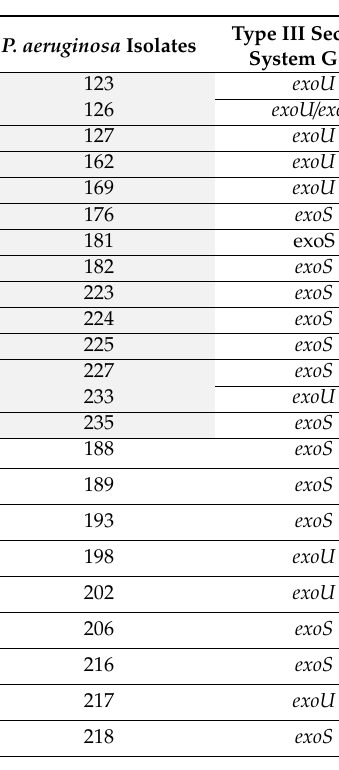
Table 4. Possession of exoU and exoS and number and type of non-synonymous mutations in the mismatch repair system genes in P. aeruginosa